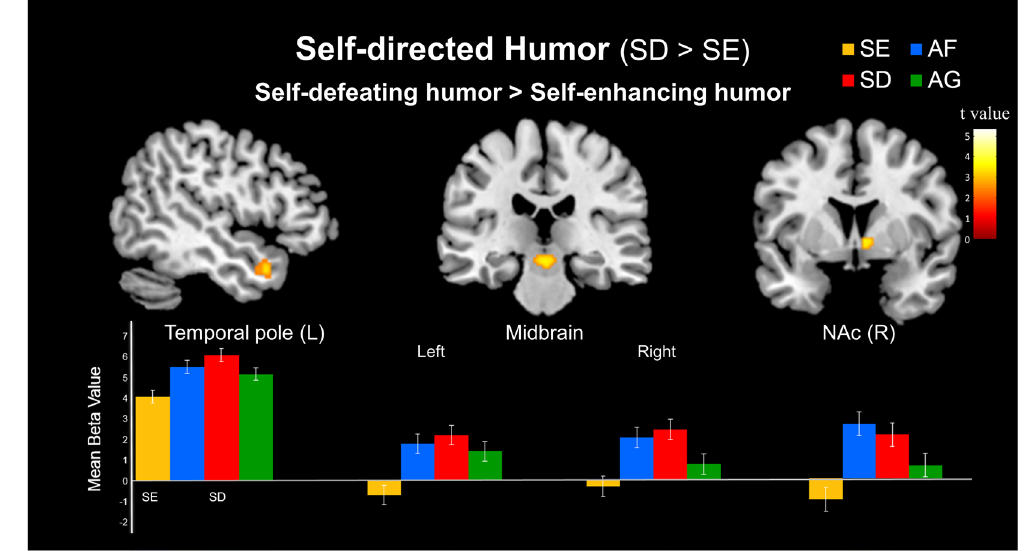
Figure 1. Simple effects of the differential neural mechanisms related to self-directed humor. (Top) Stronger responses to self-defeating humor (SD) than to self-enhancing humor (SE) in the left temporal pole, bilateral midbrain, and right nucleus accumbens (NAc). (Bottom) Parameter estimates (SPM betas) are plotted for these four regions. Standard error of the mean (SEM) bars are shown.